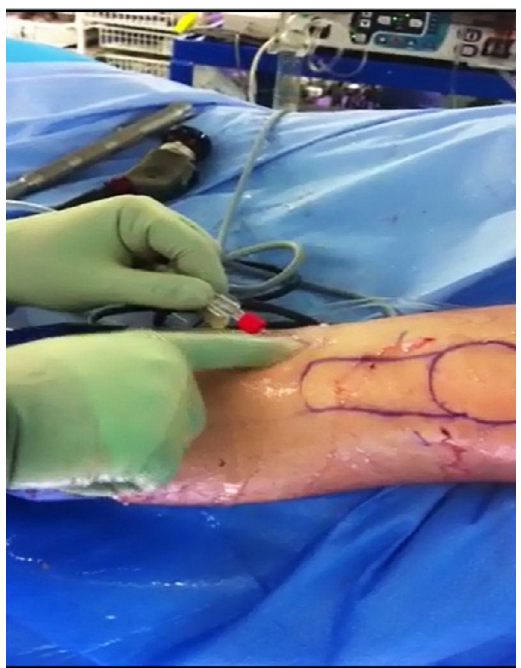
Figure 6. Debriding the tibial tunnel opening at the end of operation.